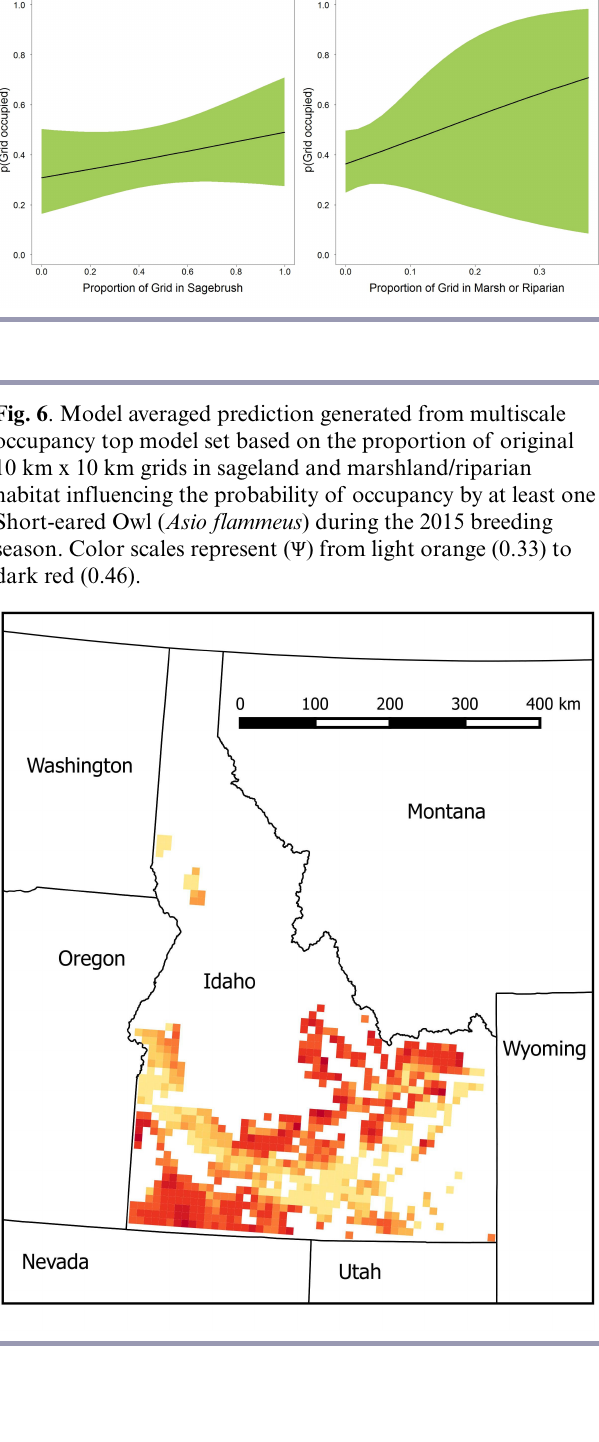
Fig. 5 . Model averaged predictions generated from multiscale occupancy top model set for the effect size of the proportion of the area within 1 km of surveyed points in (a) sageland; and (b) marshland or riparian habitat influencing the probability of occupancy of the full transect by at least one Short-eared Owl ( Asio flammeus ) during the 2015 breeding season. Black line = model prediction; green area = 95% confidence interval.